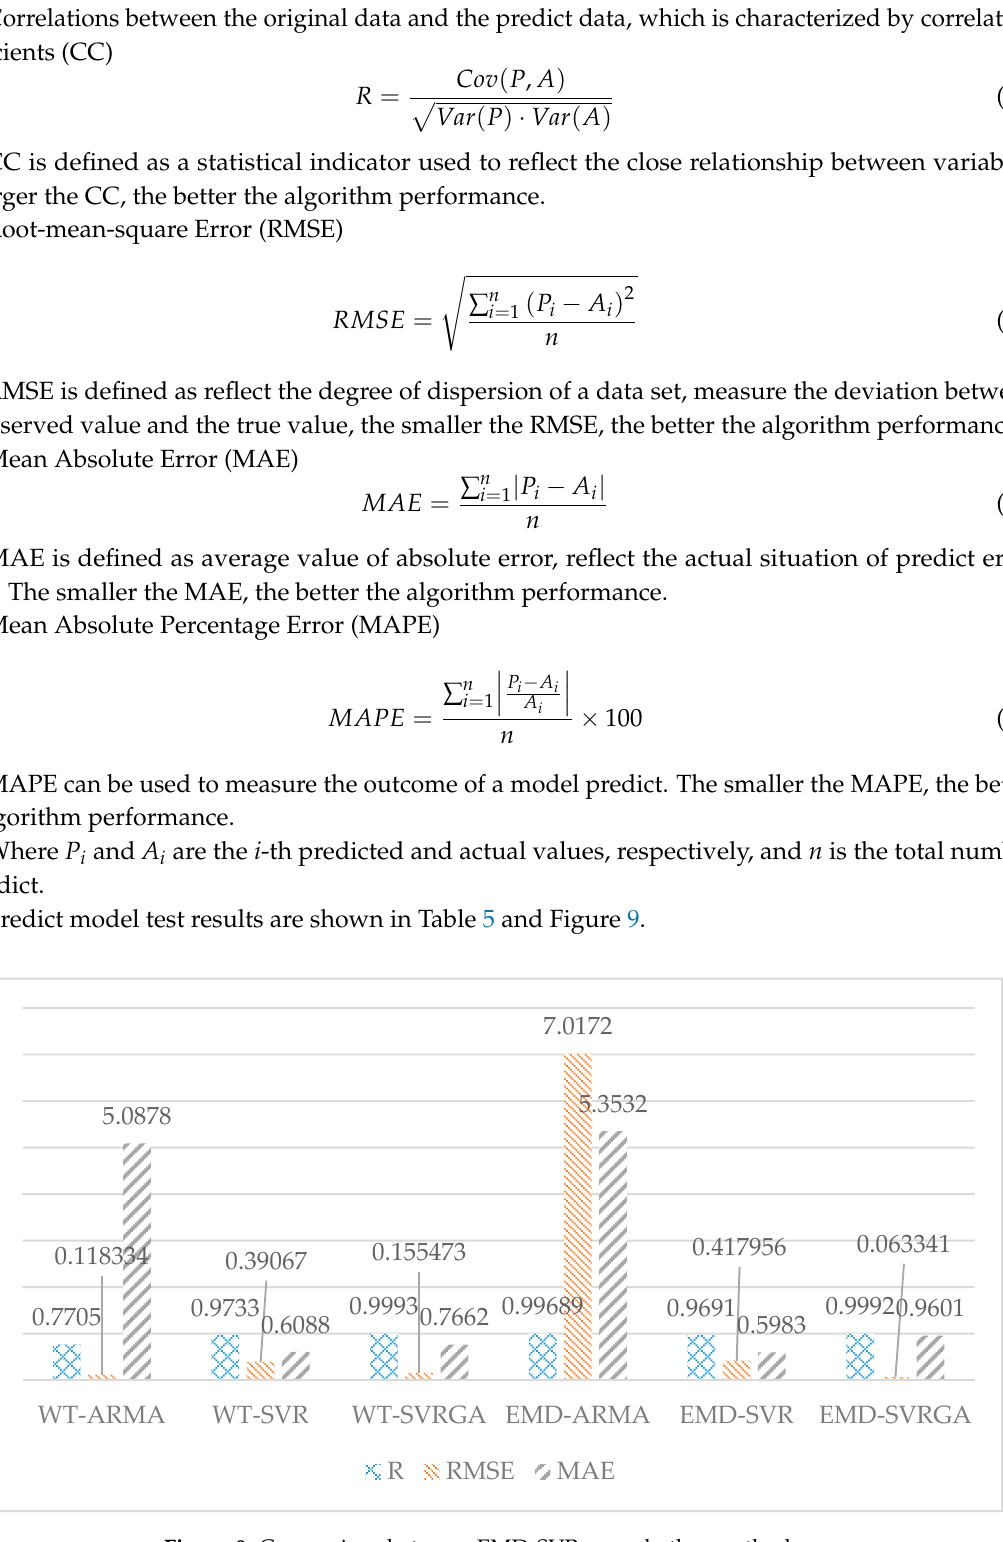
Figure 9. Comparison between EMD-SVR GA and other methods.